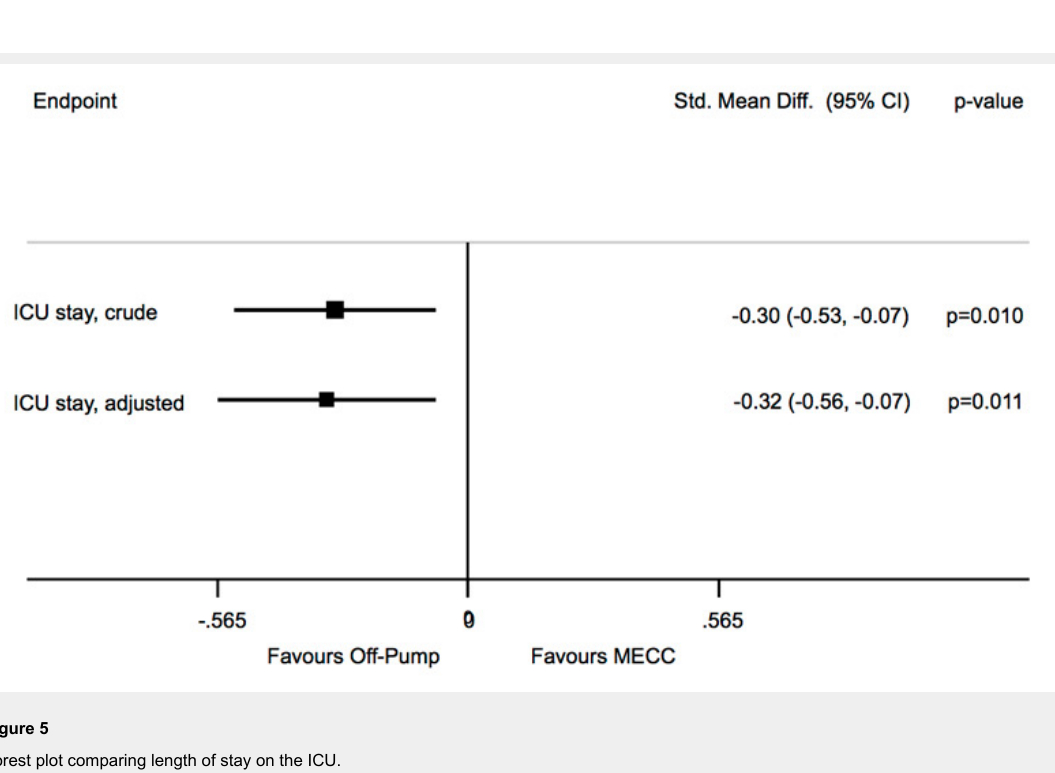
Figure 4 Forest plot regarding the values of CK-MB on the first postoperative day as well as peak level.